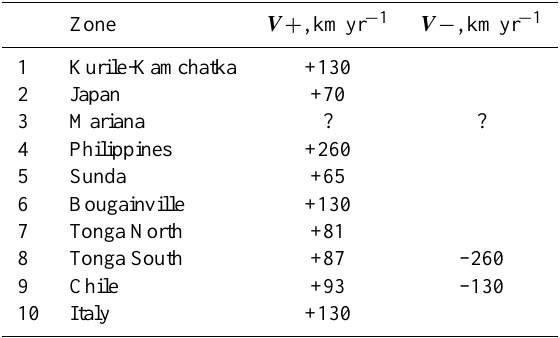
Table 2. Estimated averaged migration velocity V for the different zones: V > 0 for upward migration and V < 0 for downward